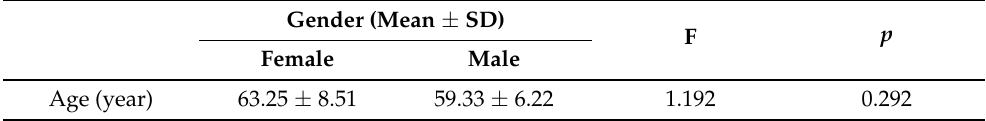
Table 2. Gender analysis of